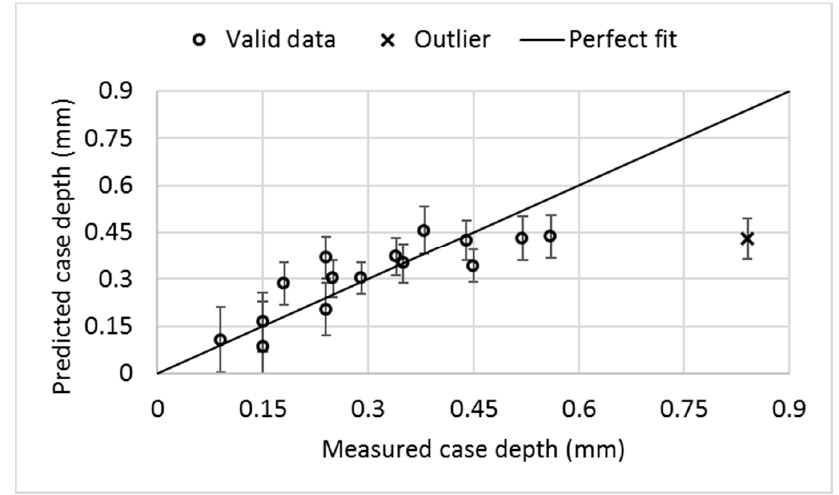
Figure 7. Predicted vs. measured case depth with the non-ground sample data set.